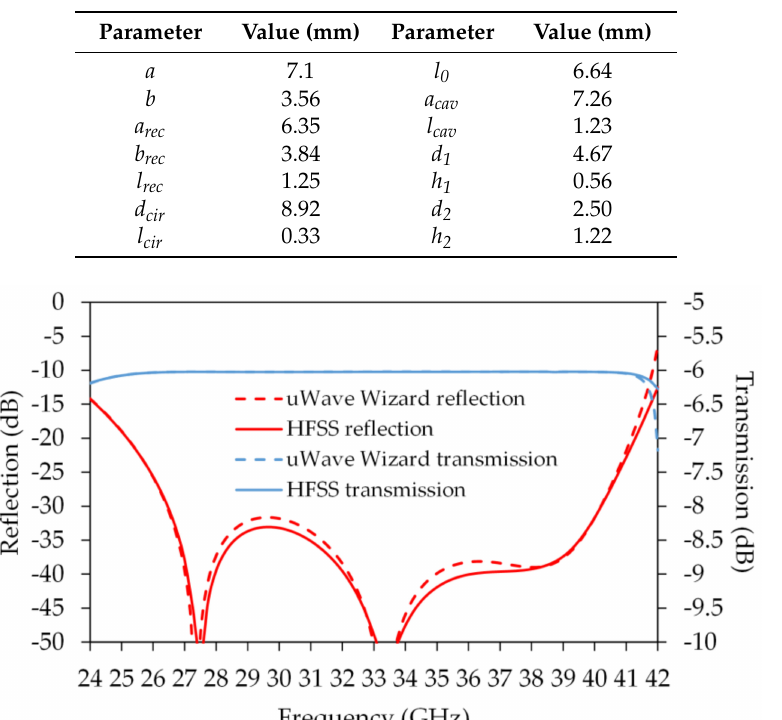
Table 1. Junction design parameters values.